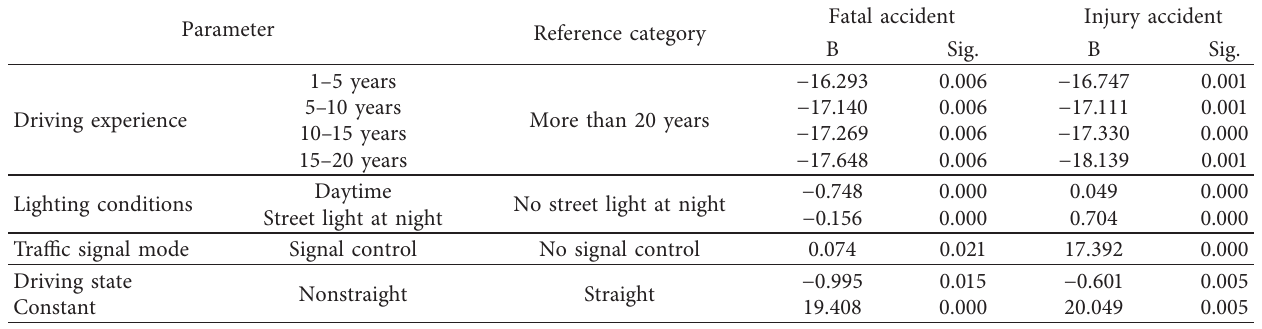
Table 4: Model calibration